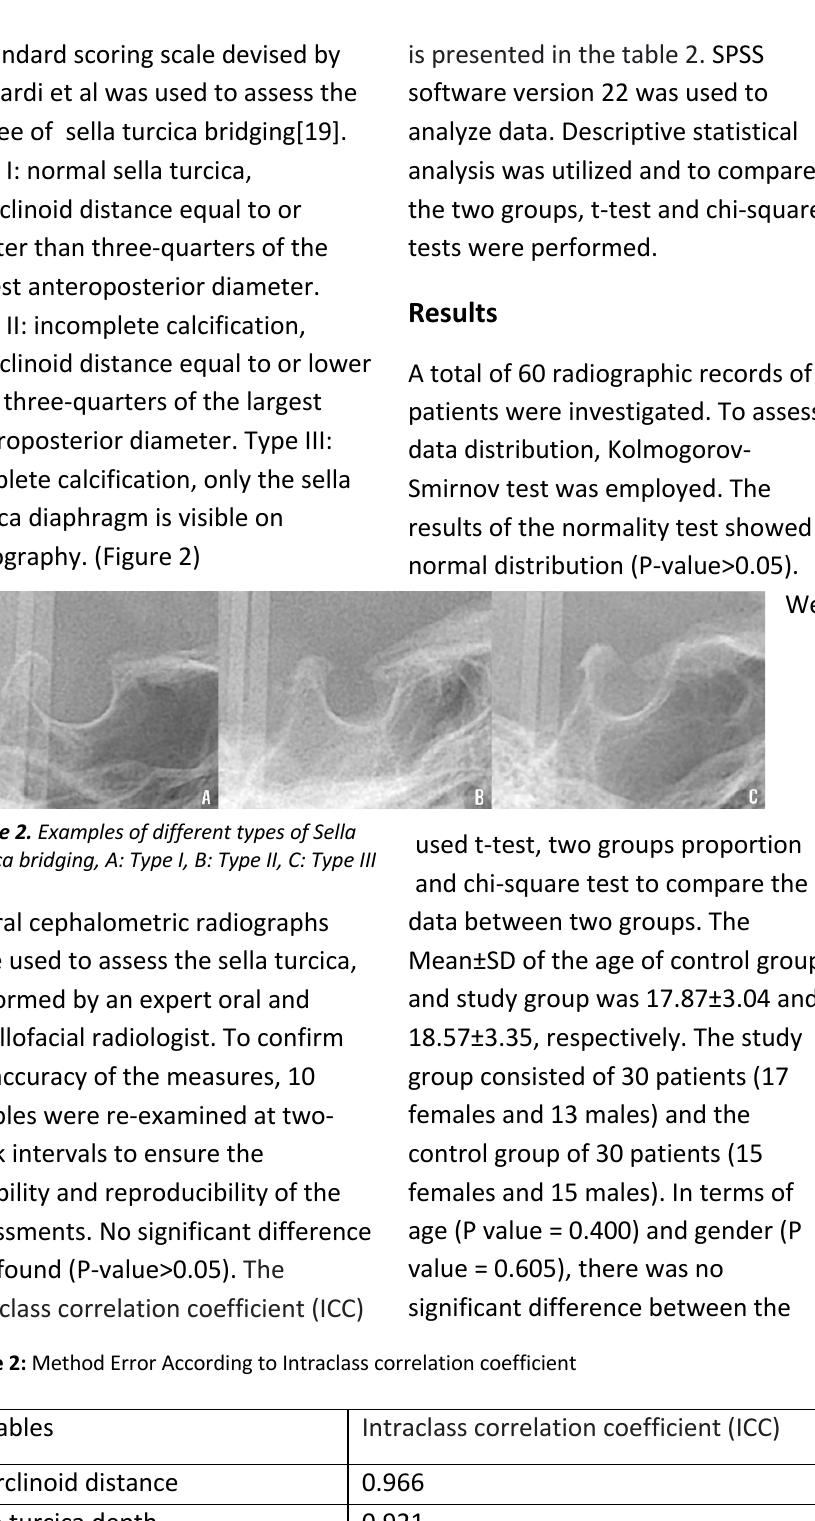
Figure 1. Two views of SCANORA version 5.2.6 software showing how to measure variables of Interclinoid distance, sella turcica depth, anteroposterior diameter of sella turcica bridging and canine angle